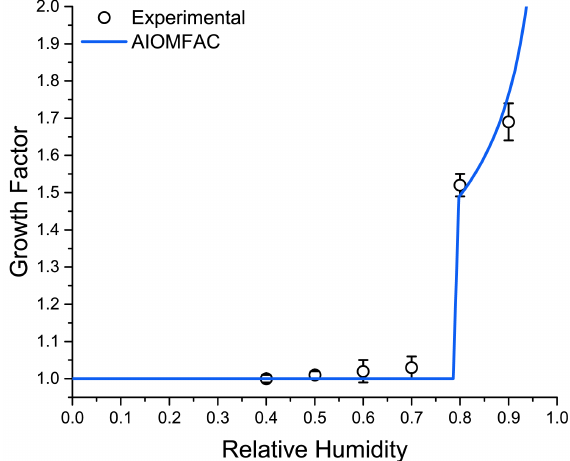
Figure B1. Measured and modeled hygroscopic growth factors for ammonium sulfate particles with dry mobility diameters of 250nm. The black circles indicate the average growth factor measured across 10 experiments and error bars indicate the standard devia- tion of the measured growth